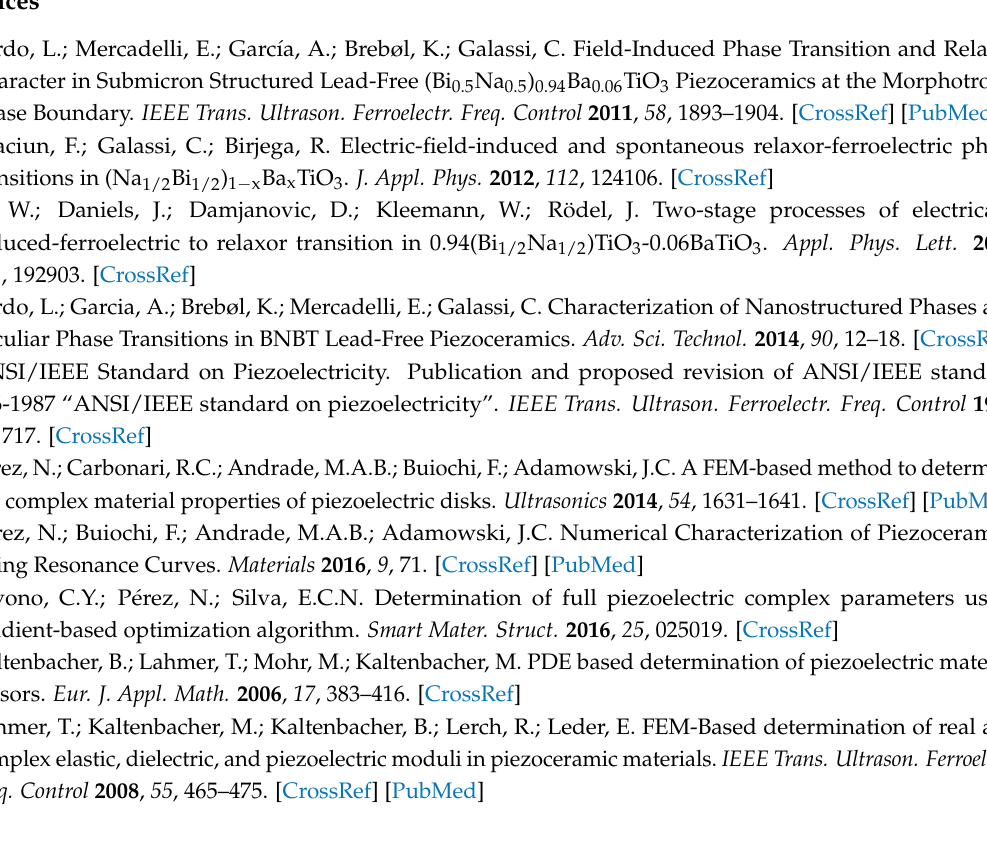
Figures: sensitivity analysis of the elastic parameters on R (Figure S1), sensitivity analysis on G (Figure S2) and on R (Figure S3) of the dielectric and piezoelectric parameters; Extreme positions of the deformation of the modes of movement of the disk at the fundamental radial resonance (Figure S4), at the fundamental thickness resonance (Figure S5), at the complex mode C1 (Figure S6) and at the complex mode C2 (Figure